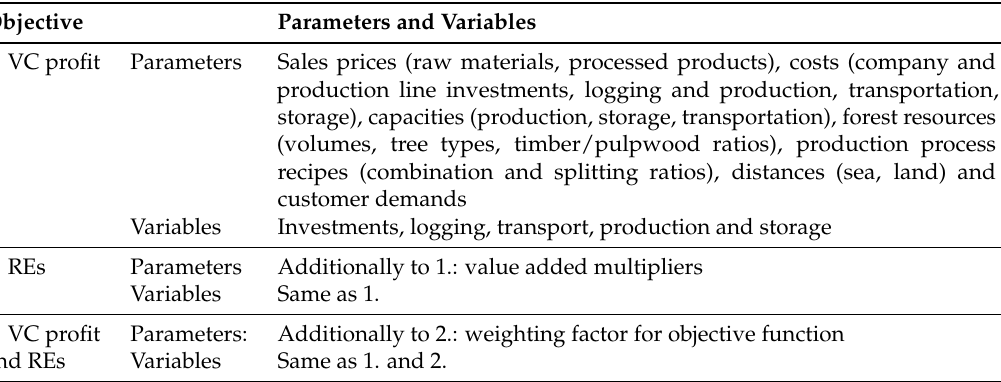
Table 1. Main model parameters and variables (VC: value chain, RE: ripple